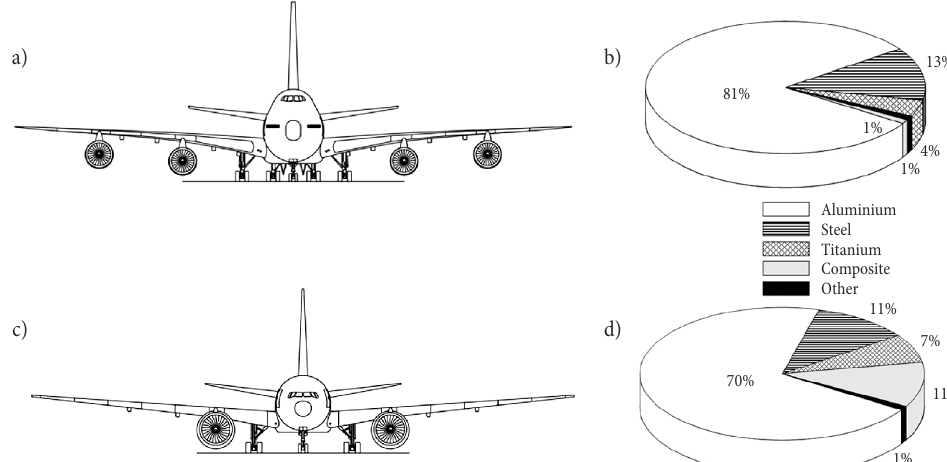
Fig. 1. Combination of materials used in Boeing aircrafts: a, b – Boeing-747; c, d – Boeing-777 (Dursun, Soutis 2014; Jones et al.